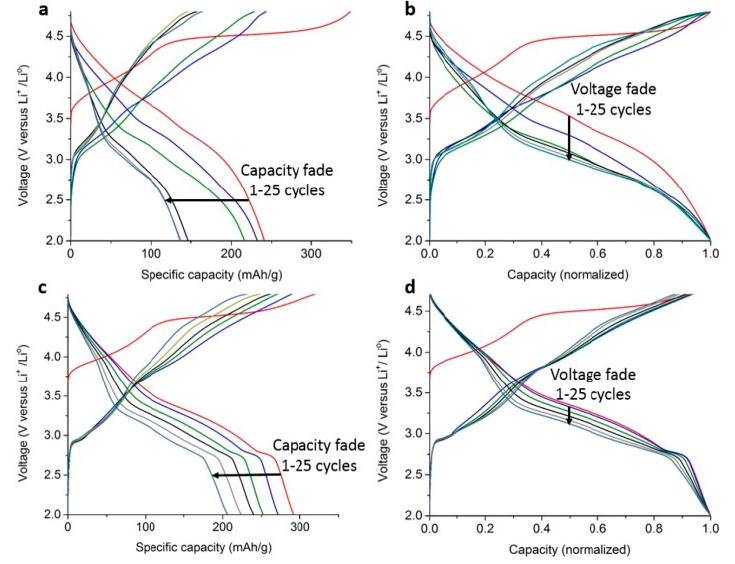
Figure 5. Voltage vs. specific capacity plots cycled at 18mAg − 1 current density for pristine Li 1.17 Ni 0.17 Mn 0.50 Co 0.17 O 2 ( a ) and ≈ 12 wt.% spinel-coated sample II ( c ); voltage vs. normalized capacity plots (maximum capacity in each cycle is taken as unity) for pristine Li 1.17 Ni 0.17 Mn 0.50 Co 0.17 O 2 ( b ) and sample II ( d ).